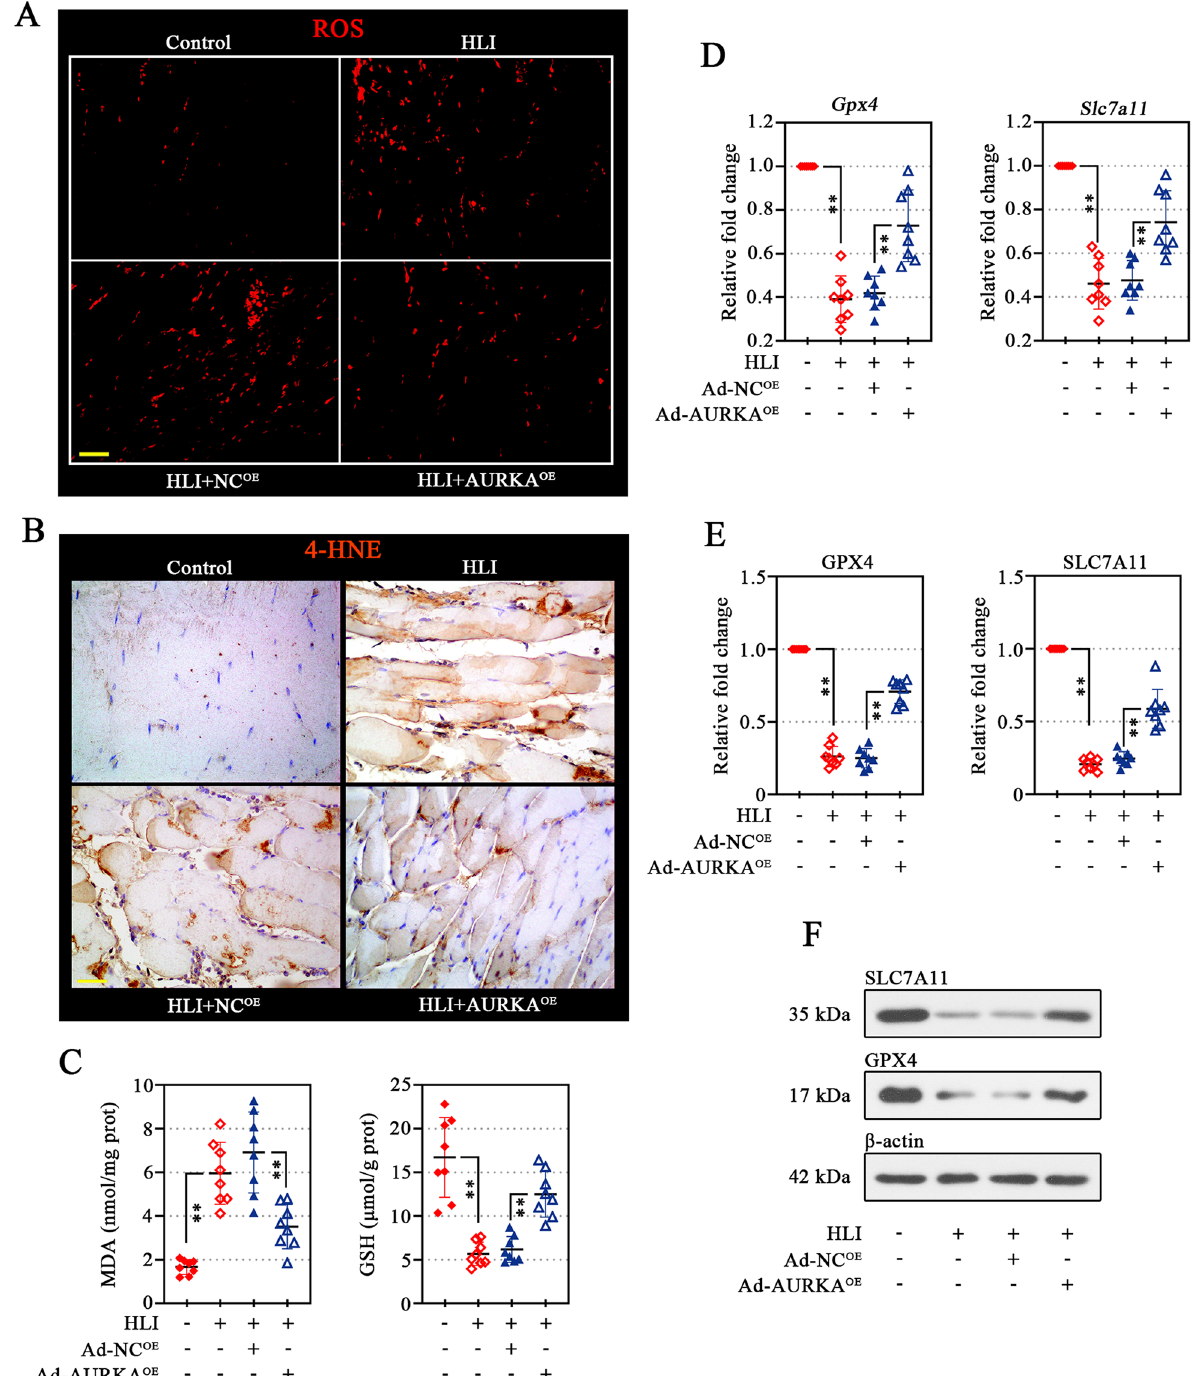
Fig. 9 AURKA overexpression rescues ischemia-induced oxidative stress in murine gastrocnemius muscle. ROS production in the gastrocnemius muscle tissues was visualized by dihydroethidium (DHE) staining. Scale bar, 50 μm ( A ). 4-HNE expression in the gastrocnemius muscle tissues as shown by immunohistochemical (IHC). Scale bar, 50 μm ( B ). MDA and GSH content was measured using commercial assay kit ( C ). Besides, the mRNA ( D ) and protein ( E , F ) expression of GPX4 and SLC7A11 was detected. Data were represented as mean biological replicate, n =